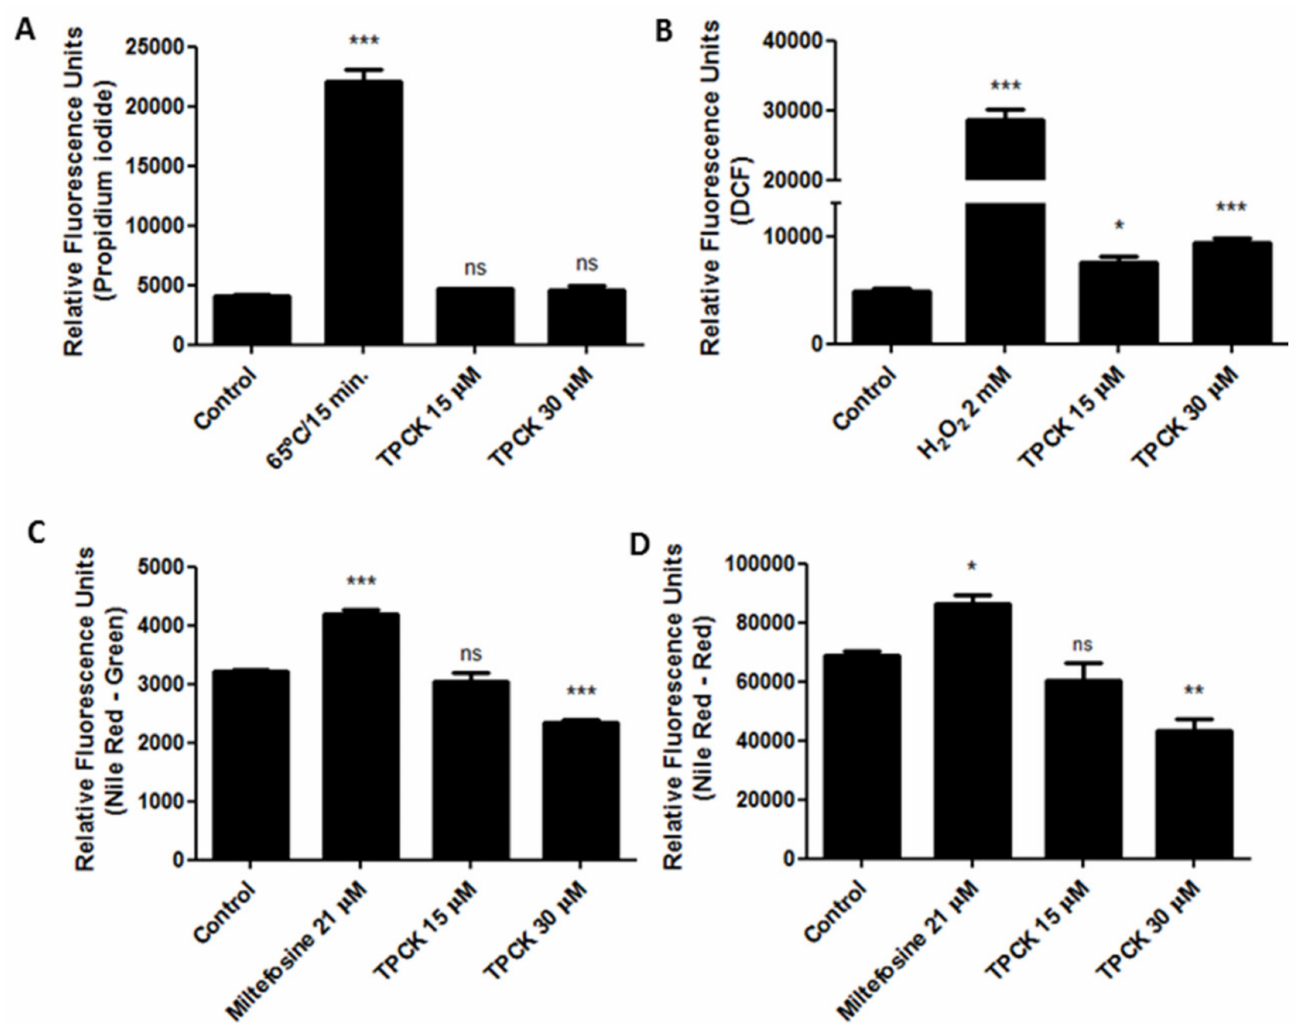
Figure 5. TPCK treatment effects on plasma membrane permeability, oxidative stress, and lipid content of L. amazonensis promastigotes. L. amazonensis promastigotes were treated with TPCK (15 and 30 µ M) for 24 h and stained with either ( A ) propidium iodide; ( B ) H 2 DCFDA; ( C ) Nile Red (green fluorescence); and ( D ) Nile Red (red fluorescence). TPCK concentrations correspond to the 1- and 2-fold IC 50 values after 72 h of incubation. Promastigotes heated at 65 ◦ C for 15 min were used as the positive controls in ( A ); 2 mM H 2 O 2 in ( B ); and 21 µ M miltefosine in ( C , D ). Statistical analyses